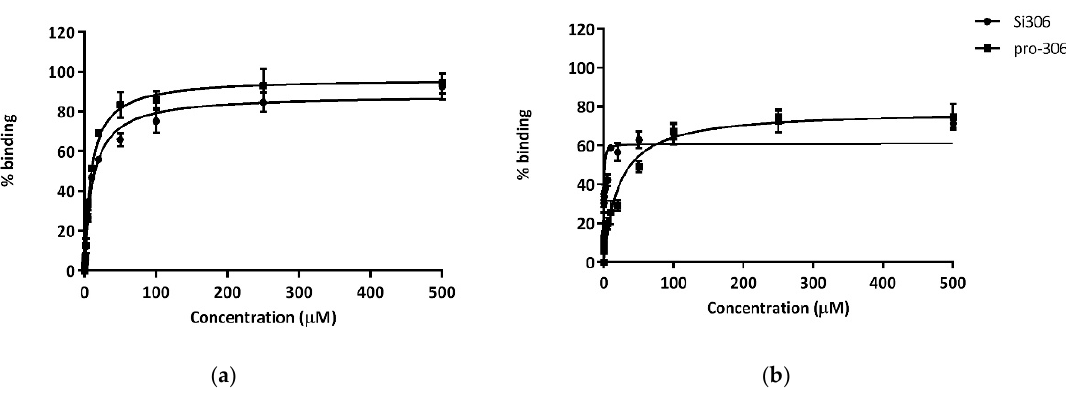
Figure 6. Binding % curves corresponding to the best fit ± S.D. of the data referring to the fluorescence quenching of AGP ( a ) and HSA ( b ) exposed to a 0–500 µM concentration range of Si306 and pro-Si306 which is reported on the x axis ( n = 3).